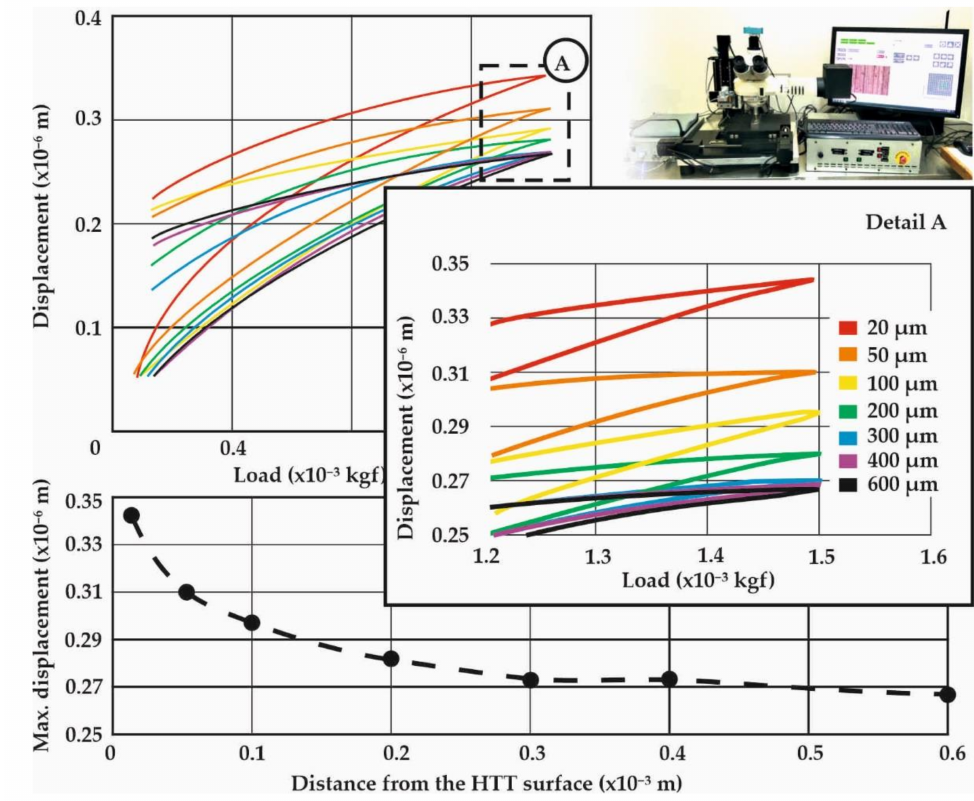
Figure 8. Nanoindentation load-displacement diagrams for the HTT leaf spring specimens at charac- teristic distances from the